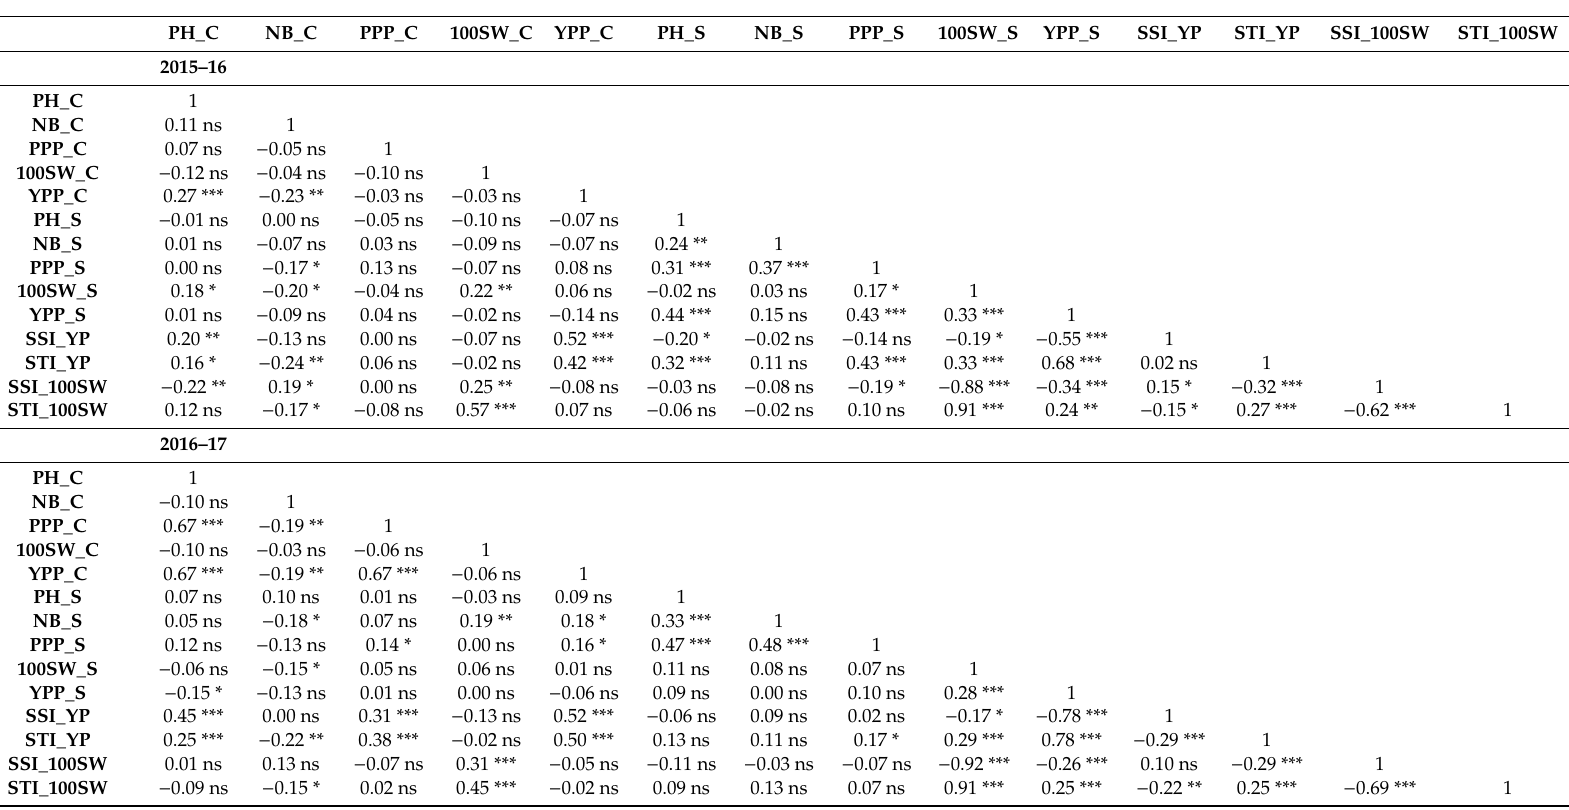
Table 2. Pearson correlation analysis for salinity tolerance component traits evaluated during the 2015–16 and 2016–17